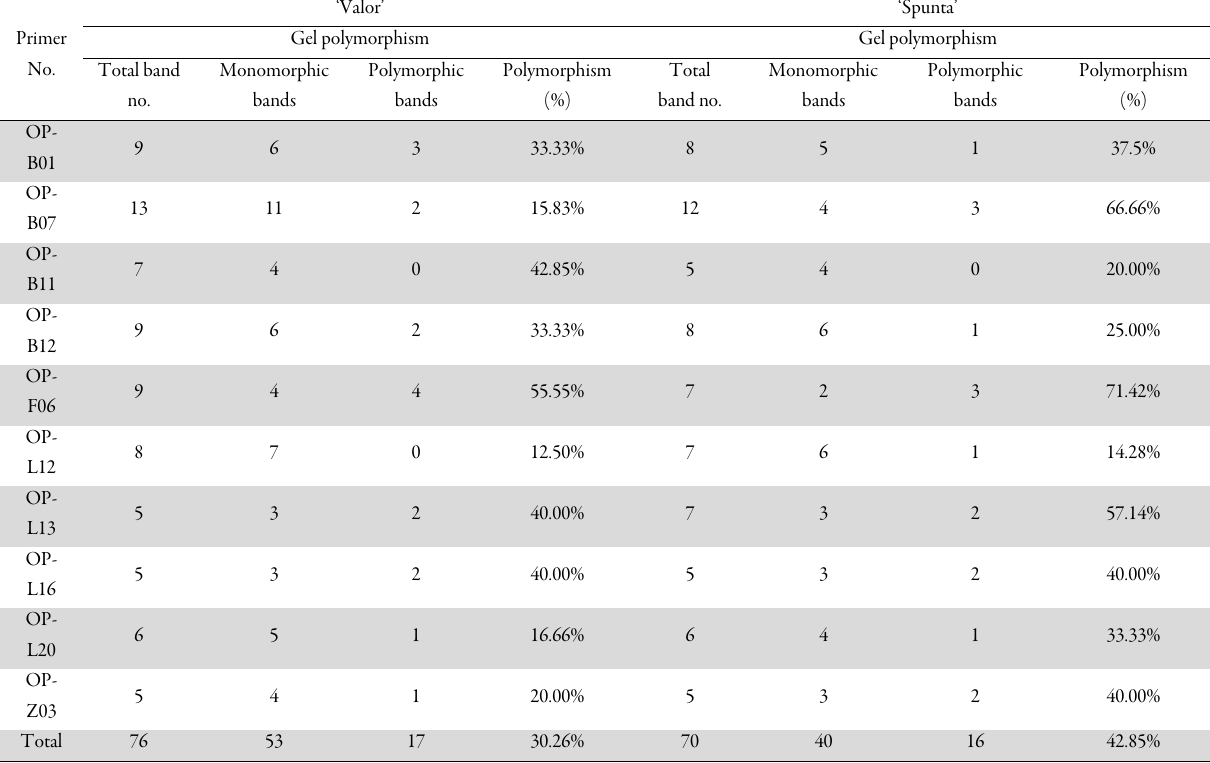
Table 3. Number and percentage of polymorphic loci obtained in 10 potato gamma radiation treatments on cvs. ‘Valor’ and ‘Spunta’